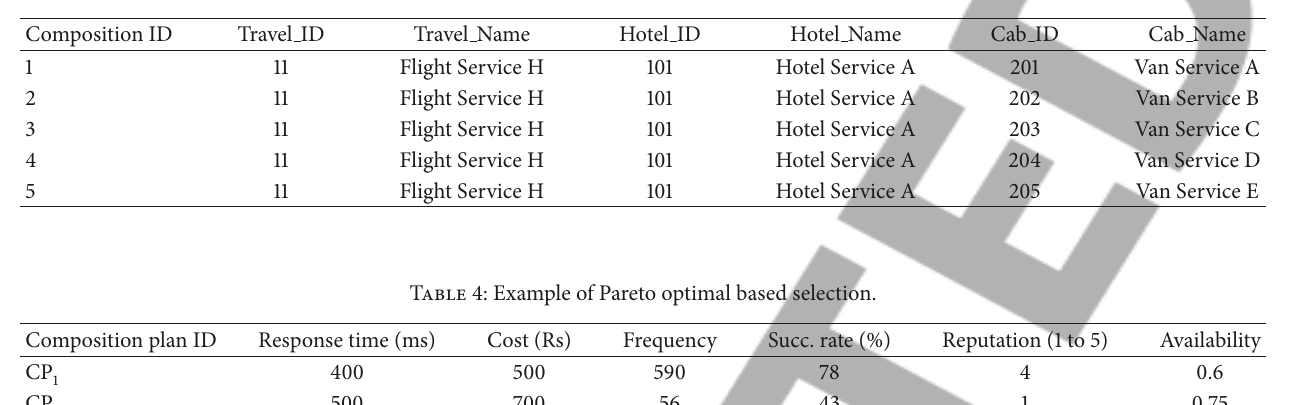
Table 3: Service composition table.